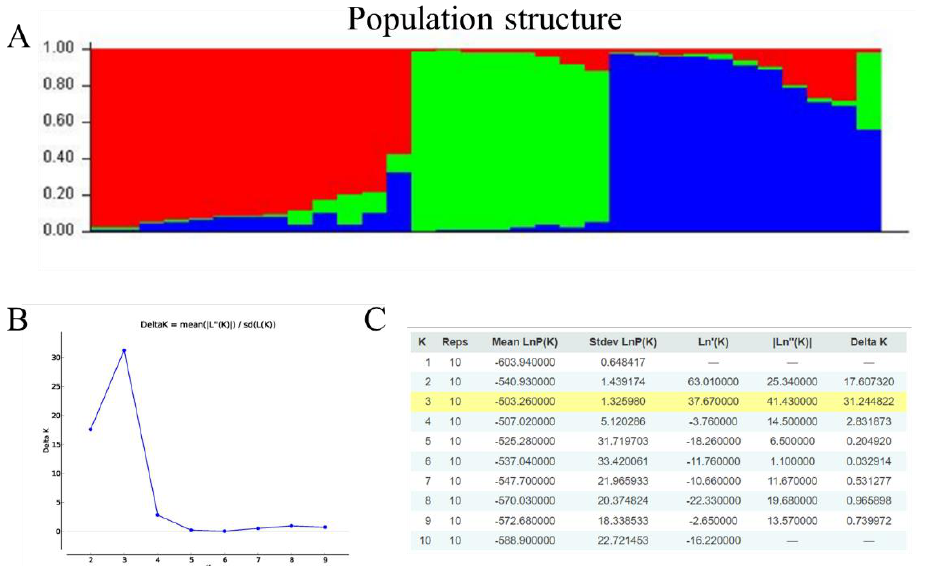
Figure 5. Population structure analysis of 32 Chinese yam accessions. ( A ) Population structure based on K = 3. When K = 3, red: Group 1; green: Group 2; blue: Group 3. ( B ) Delta K based on the rate of change of L (K) between successive K values. ( C ) Evanno table output.